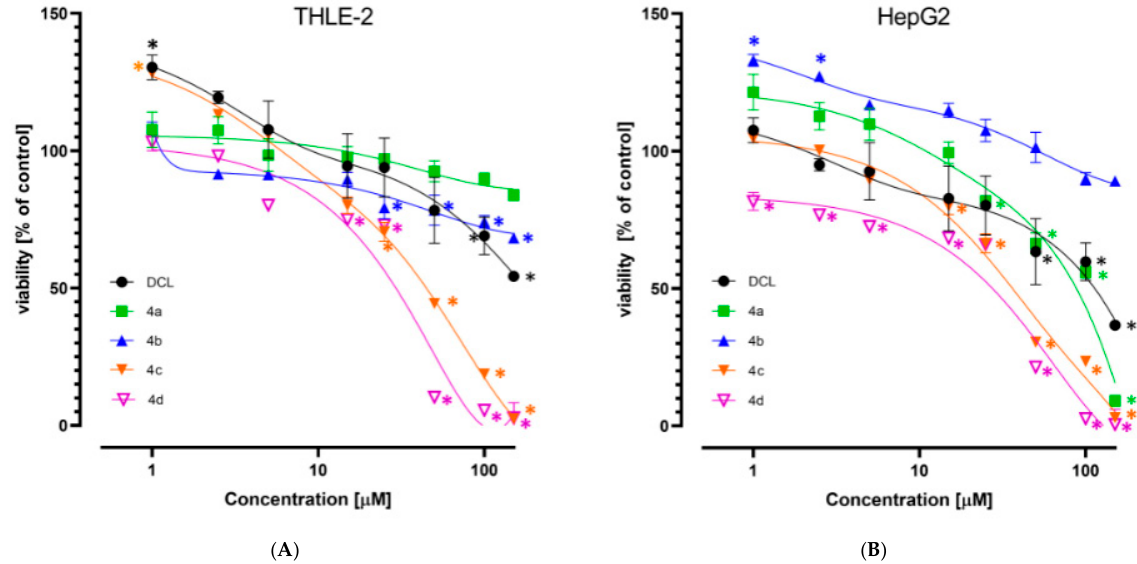
Figure 2. The effect of the DCL and DCL–OAO derivative conjugates ( 4a – 4d ) on the viability of THLE ‐ 2 ( A ) and HepG2 ( B ) cells (after 24 h incubation). Data (mean ± SEM) from three separate experiments are presented. * Significantly different from control—DMSO ‐ treated cells, p < 0.05. Statistical significance was assessed by Student’s ‐ t ‐ test. Table 1. Comparison of the DCL and DCL–OAO derivatives cytotoxicity in THLE ‐ 2 and HepG2 cells *.